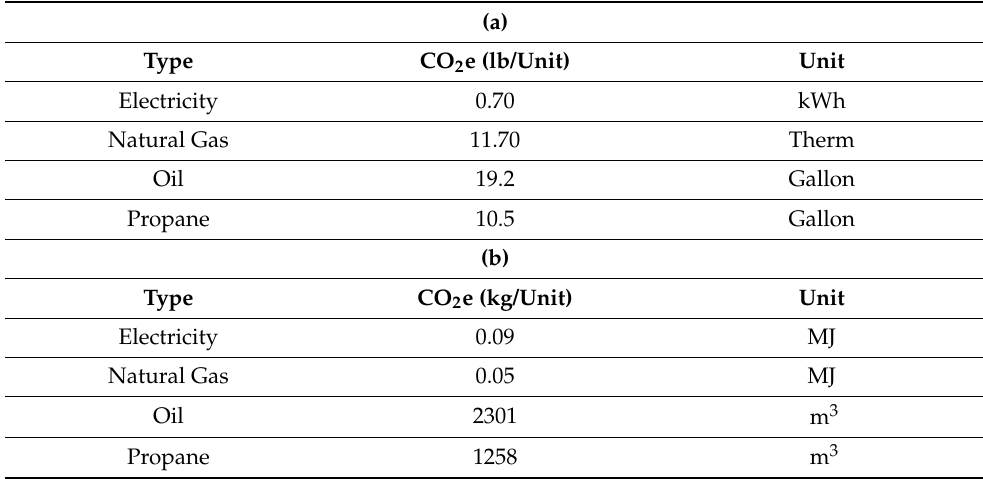
Table 1. Carbon emission factors used for TSPR calculations in the Washington State Energy Code. ( a ) IP units; ( b ) SI